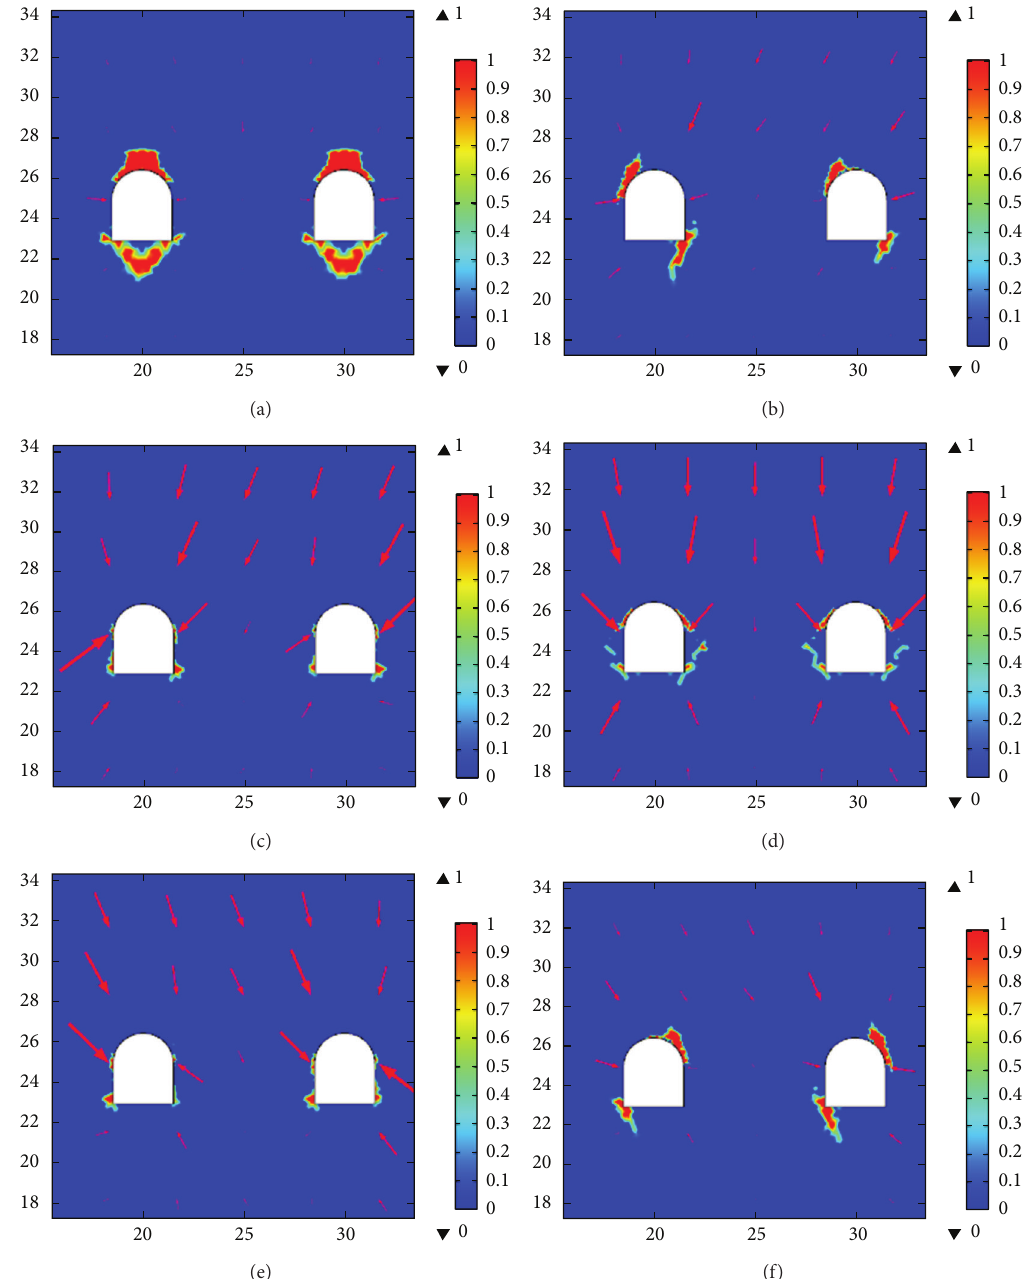
Figure 25: The damaged zone under different principal elastic directions (red arrows represent the flow velocity